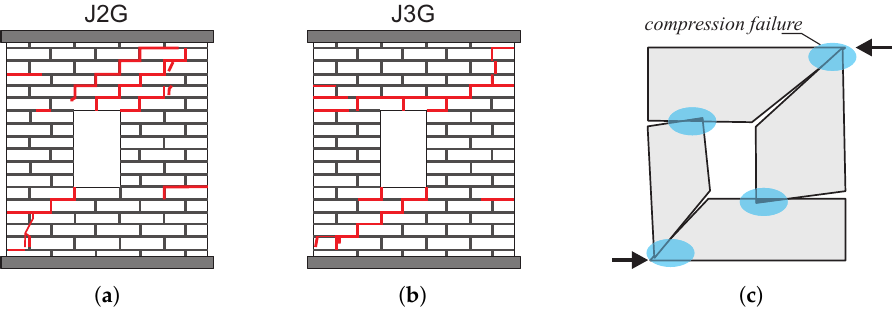
Figure 14. Experimental crack pattern at failure load [43] ( a , b ). ( c ) Mechanism of